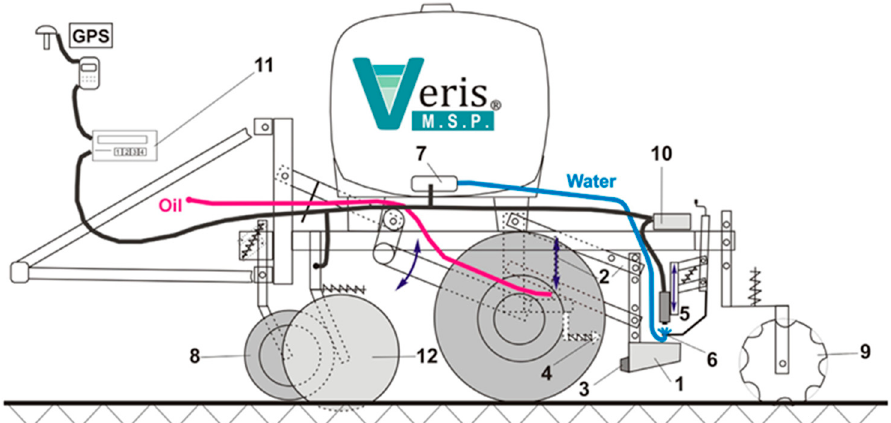
Figure 10. Veris multi sensor platform (MSP) with the Soil pH Manager: 1—soil sampler shoe; 2—parallel linkage; 3—adapter; 4—scraper; 5—pH sensors; 6—water supply with nozzles; 7—water pump; 8—row cleaner; 9—furrow closer; 10—controller; 11—data recorder; 12—sensor of apparent electrical conductivity [16].